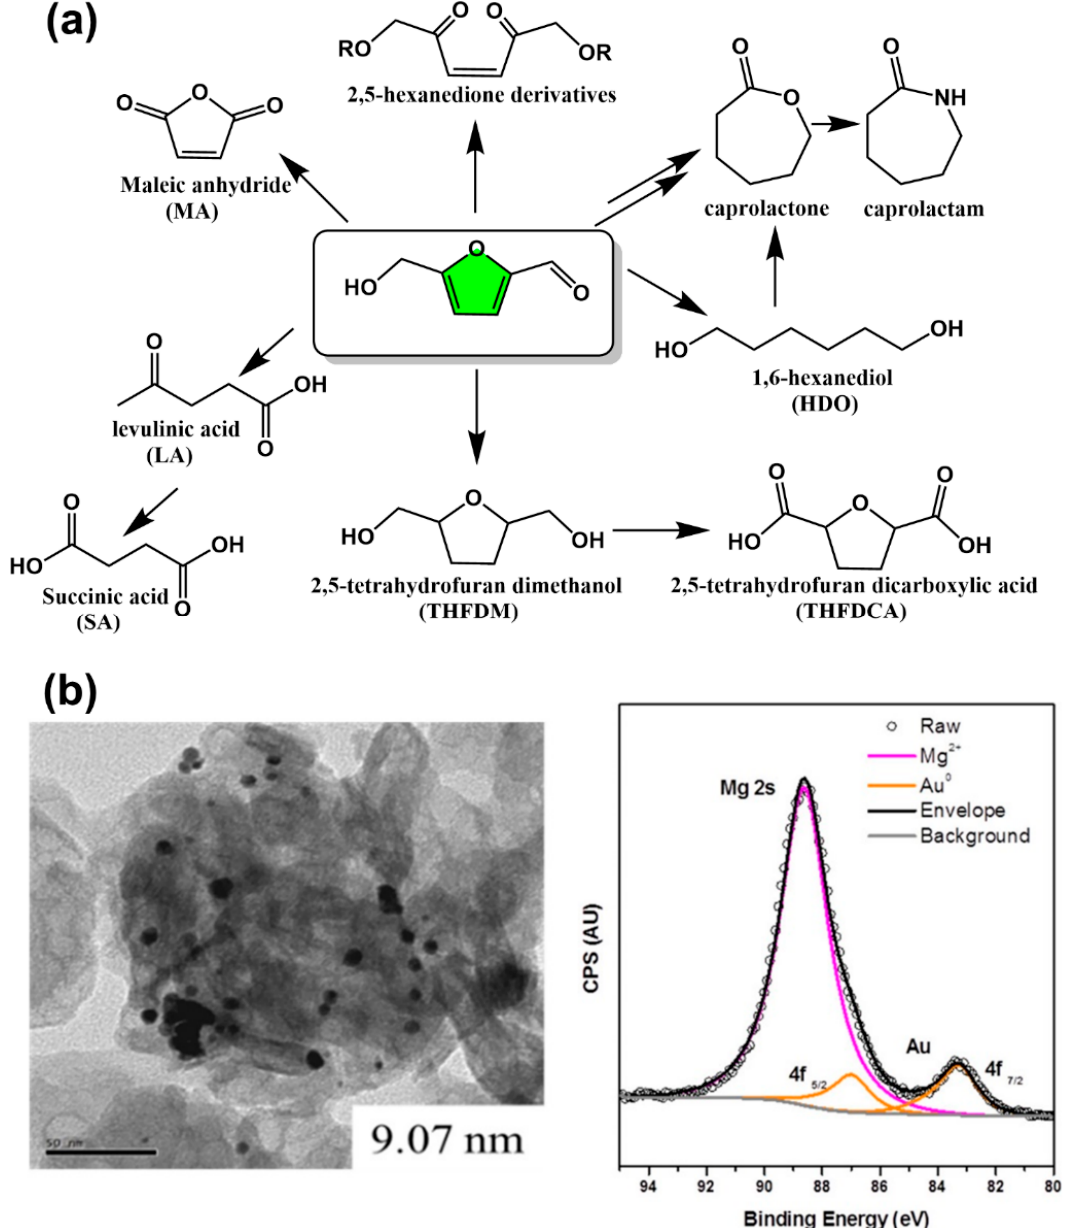
Figure 4. ( a ) 5-HMF-derived bio-based monomers without furan ring structures and ( b ) AuNP/HT catalyst for efficient conversion of THFDM to THFDCA [33]. Reprinted/adapted with permission from Ref. [33]. Copyright 2019, American Chemical Society.